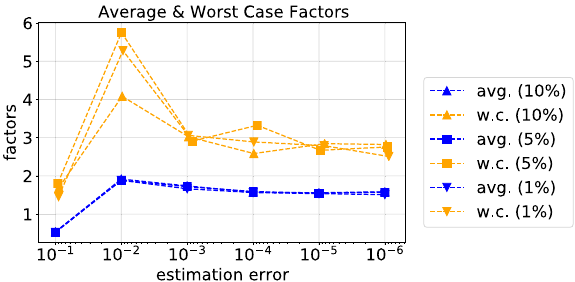
Fig. 4 Analysis of constant overhead for Chernoff-Hoeffding IQAE. The average (blue) and worst-case (orange) constant over- head for IQAE runs with different parameter